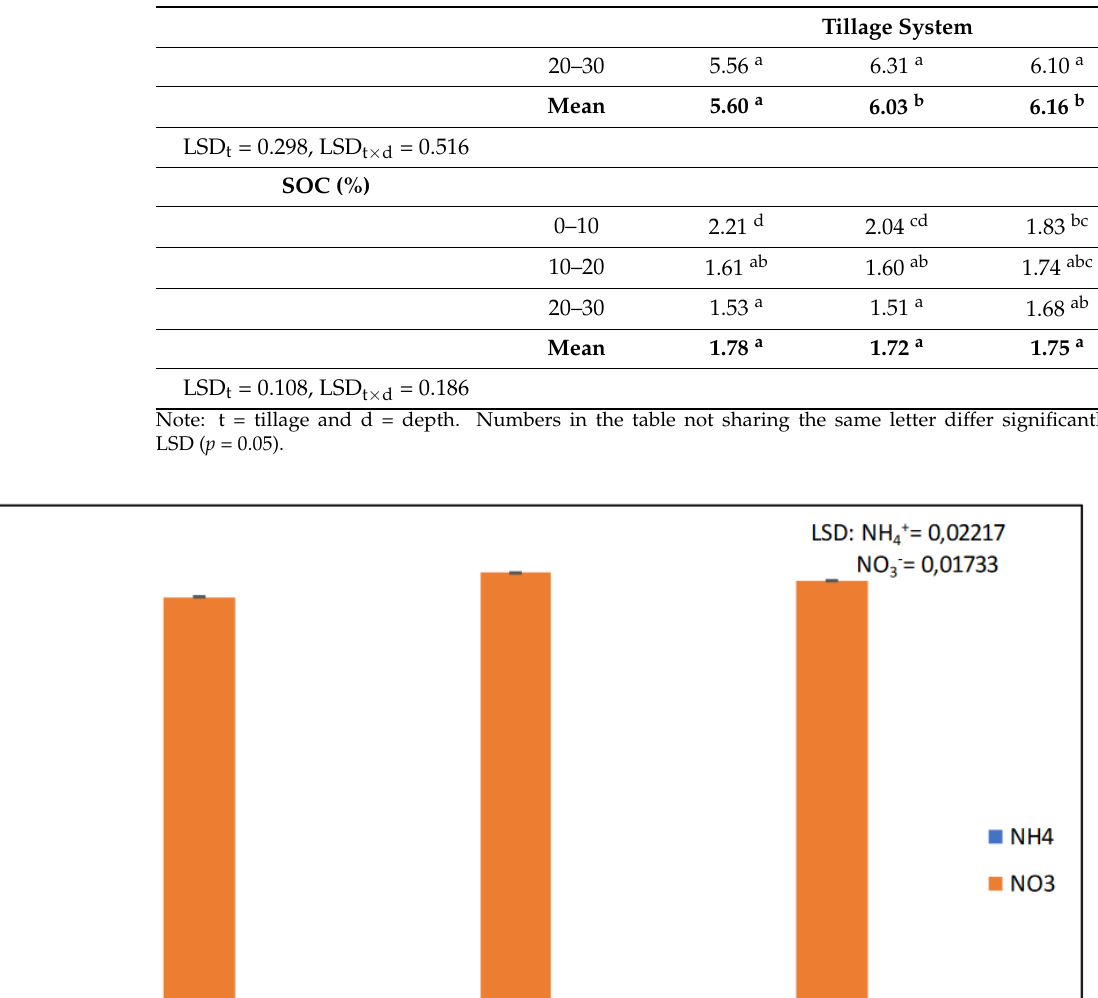
Table 2. Soil pH and SOC measured 17 years after implementation of the trial at different soil depth and under different tillage treatments (NT, CT, and RT). Table 2. Cont .